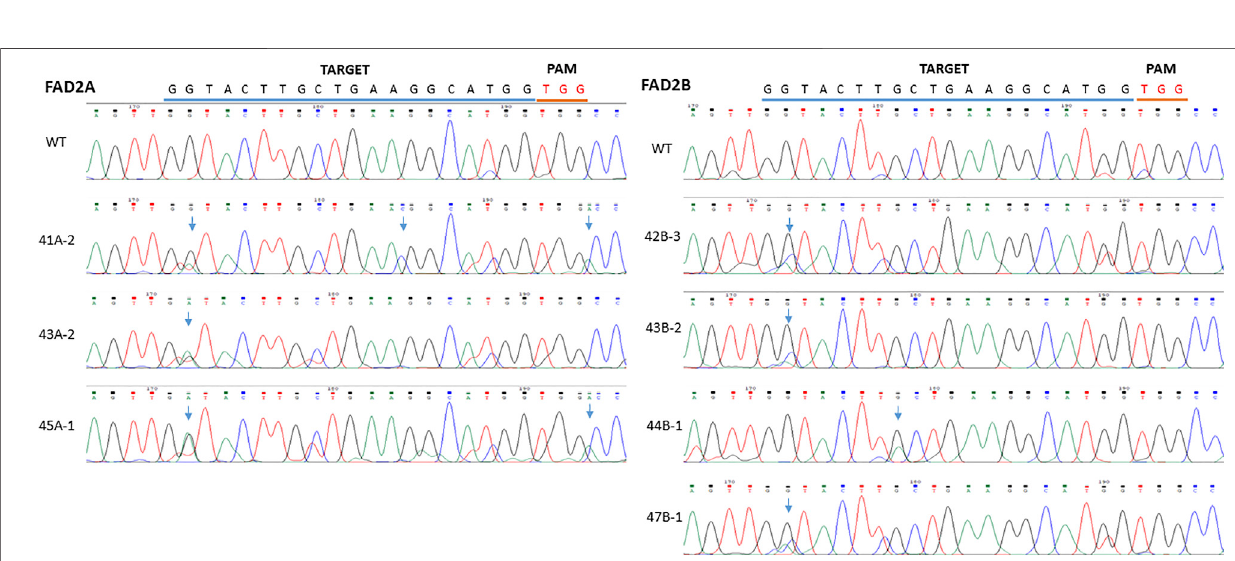
Frontiers in Genome Editing |